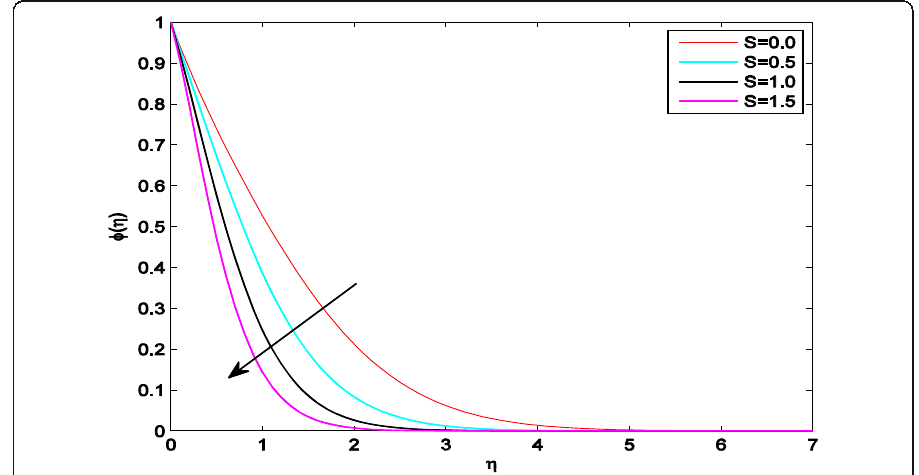
Fig. 8 Concentration graph for various values of